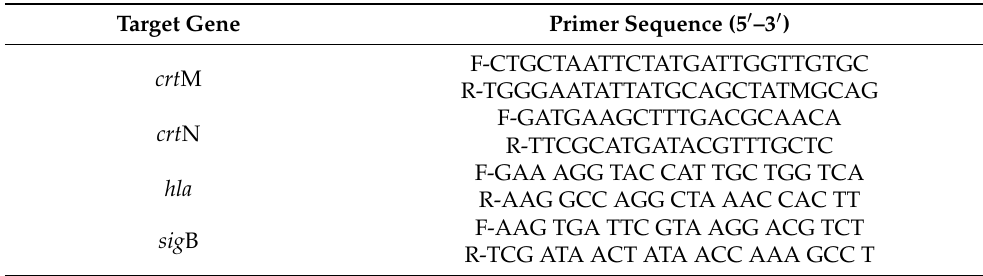
Table 3. List of primers used for qPCR analysis. Target